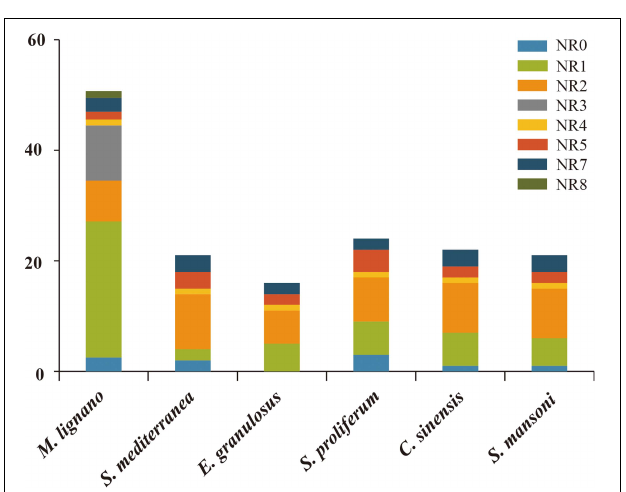
FIGURE 4 | Different distribution patterns of NR genes in flatworms. The x -axis represents the species, and the y -axis represents the gene numbers in different